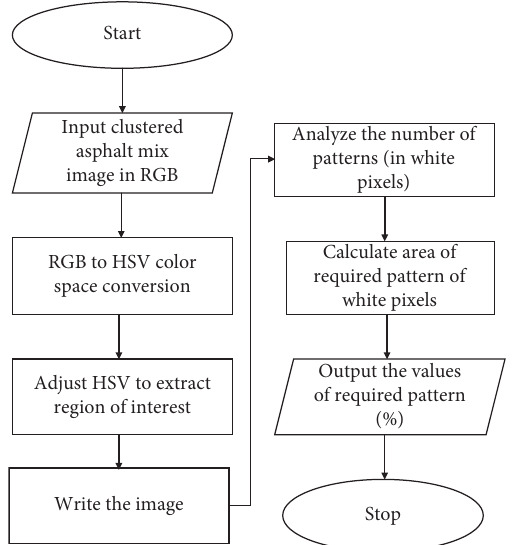
Figure 3: Process of image